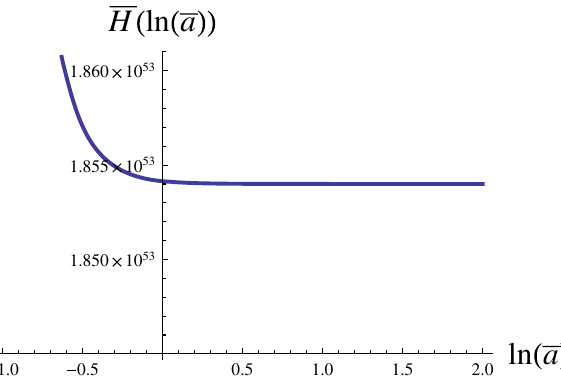
Fig. 5 Illustration of the typical evolution of ¯ ρ φ with respect to ln ( ¯ a ) at the beginning of the inflation epoch. We assume that γ = 1 . 16 × 10 − 69 s 2 and ¯ a 0 = 1 at the beginning of the inflation epoch. ¯ ρ (cid:17) is expressed in units of km 2 . Note that during the inflation ¯ ρ φ ≈ const s 2 Mpc 2